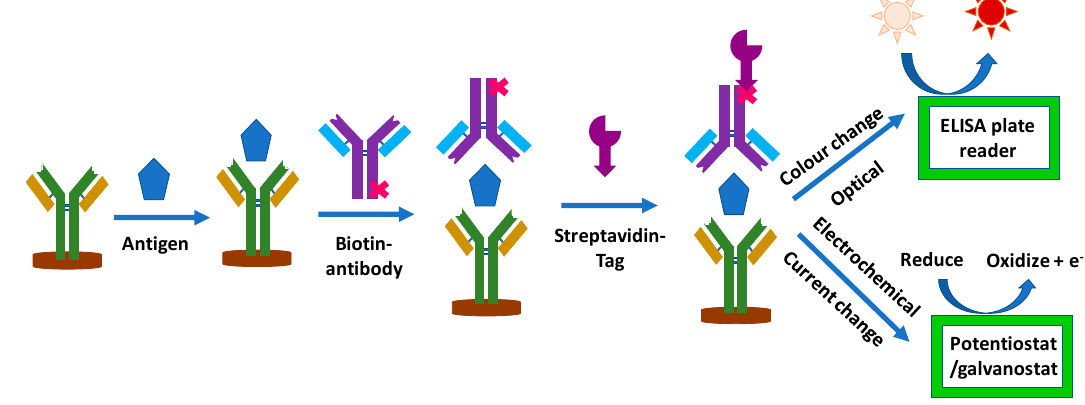
Figure 1. General schematic for immunosensor functioning and detection.